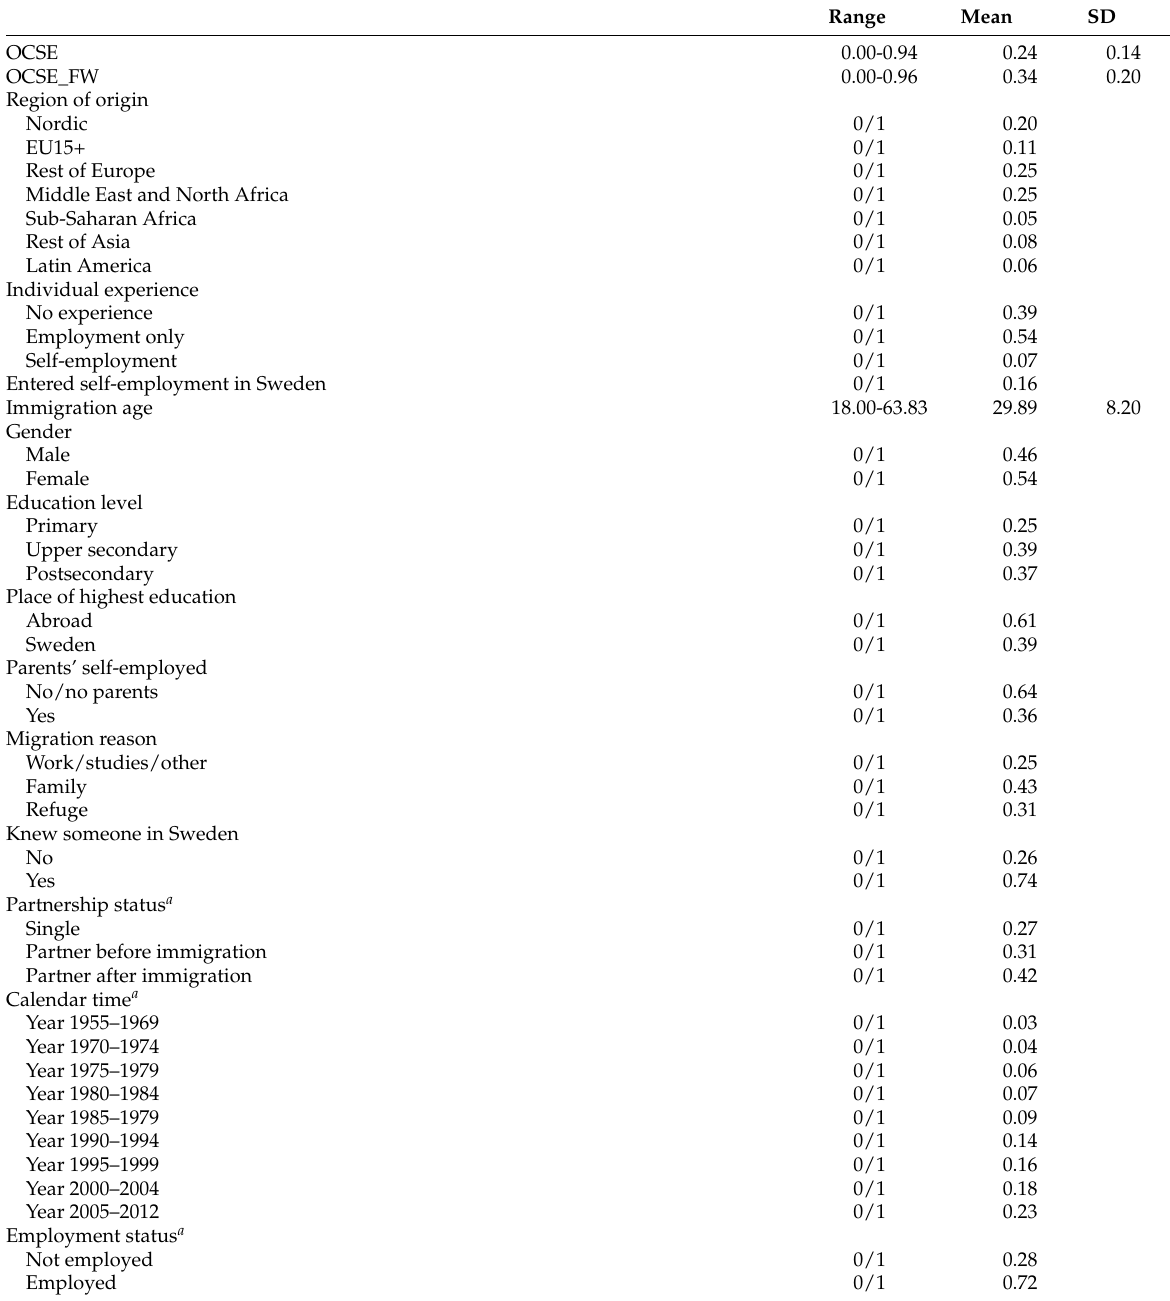
Table 1: Descriptive